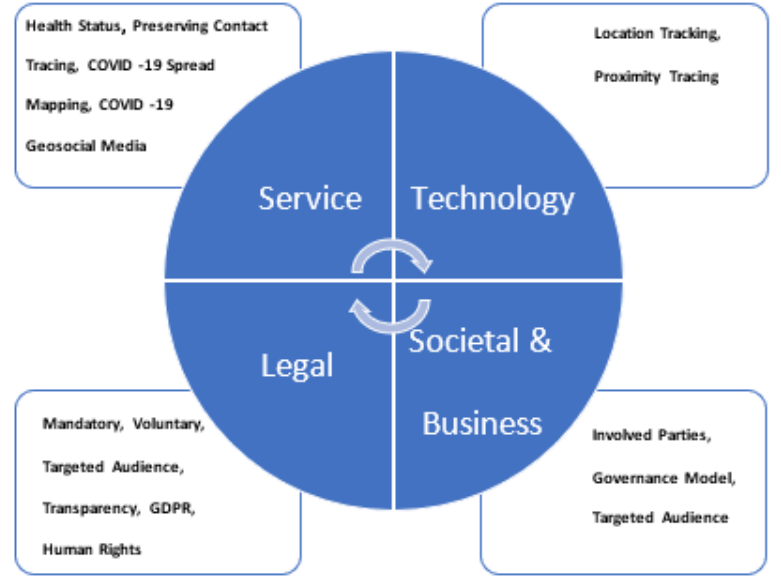
Figure 1. COVID-19 LBMAs Framework.